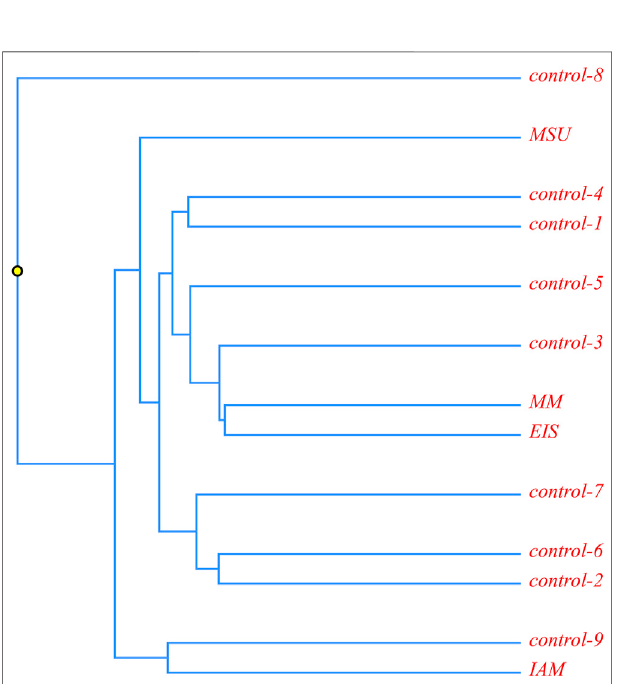
FIGURE 3 | Phylogenetic analysis of ethnic Chechen children with the c.518A > G pathogenic variant; and control samples without it.